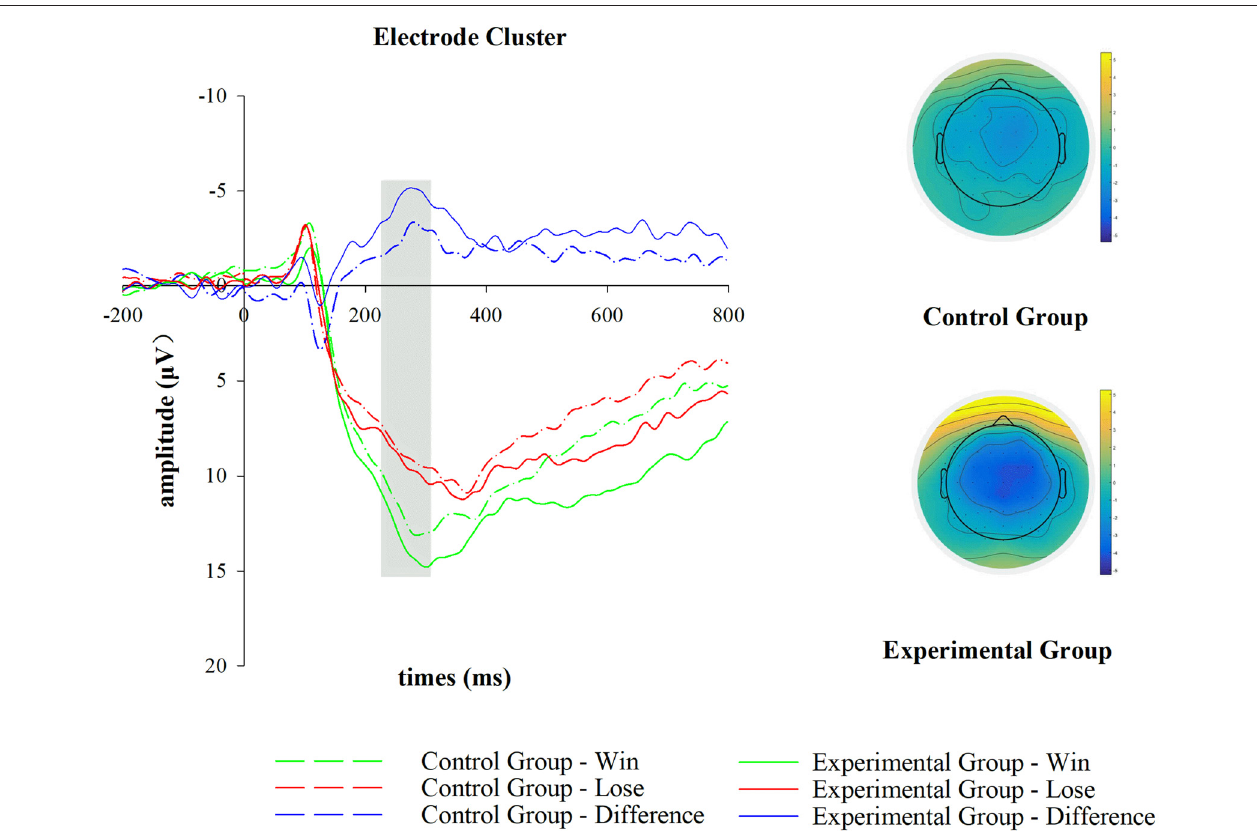
FIGURE 2 | Feedback-related negativity (FRN) results during the outcome appraisal stage. For illustration, grand-averaged event-related potential (ERP) waveforms of FRN and FRN loss-win difference wave (d-FRN) from the electrode cluster (FC1, FCz, FC2) are shown for group (control group versus experimental group) and outcome (win versus lose) conditions. The scalp topographic distribution of d-FRN is provided for control and experimental groups, and the bar for the topographic map ranges from − 5 µ V to 5 µ